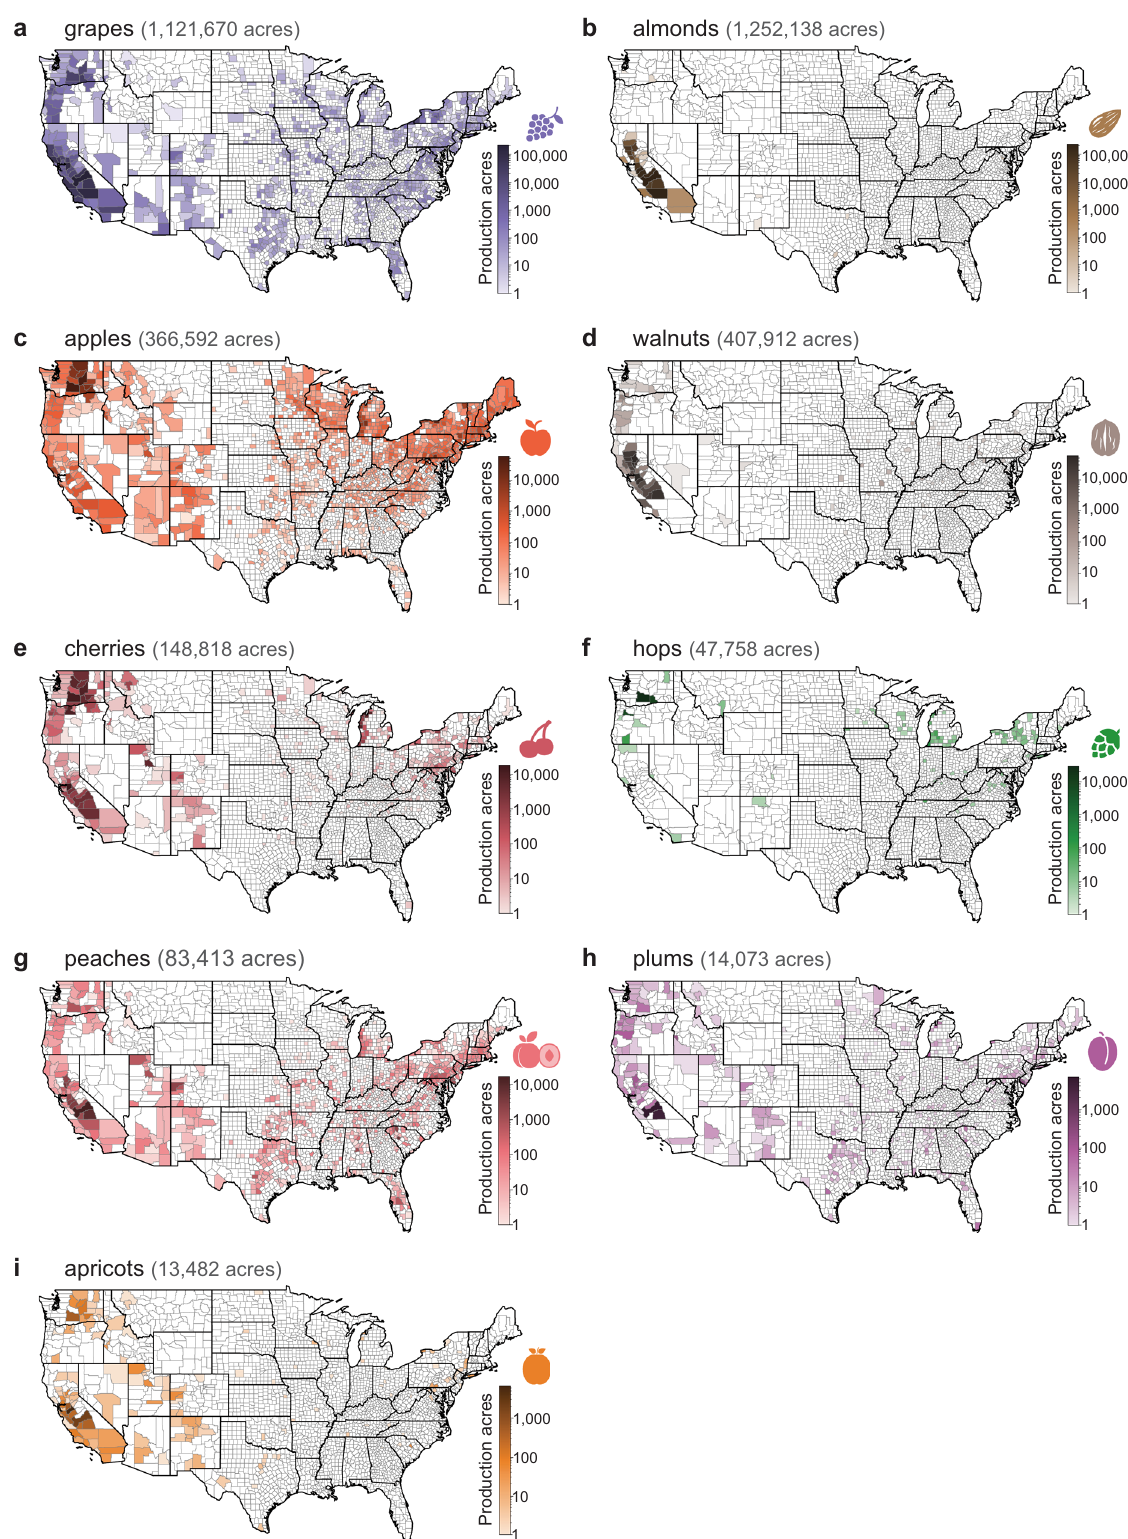
Fig. 3 Crop production for top at-risk commodities. USDA county-level production data in acres for crops from the National Agricultural Statistics Service Census 2017 by county ( a ) grapes, b almonds, c apples, d walnuts, e cherries, f hops, g peaches, h plums, i apricots 10